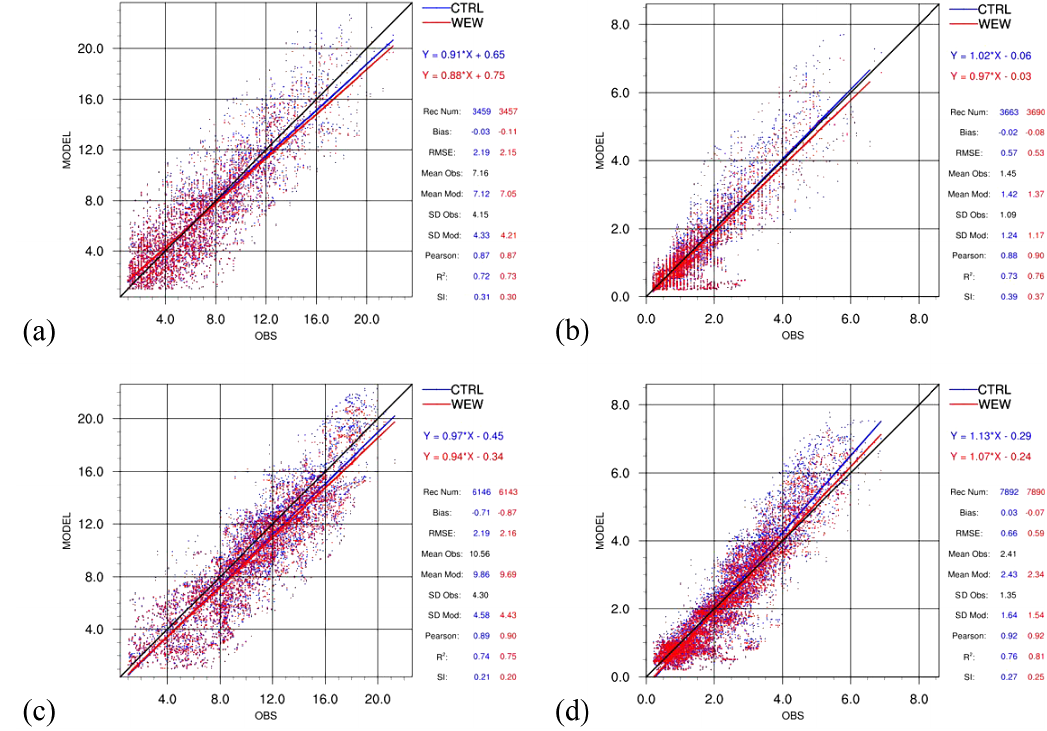
Figure 12. Scatter plots of the near-surface wind speed exceeding 1ms − 1 (a, c) and the significant wave height exceeding 0.2m (b, d) against the network of the Mediterranean buoys (a, b) and the remotely sensed retrievals (c, d) for the period 4–11 January 2012. y axis presents the model-estimated values and x axis the buoys observations (a, b) and the satellite estimations (c, d) . CTRL and WEW evaluation results are shown in blue and red colors,